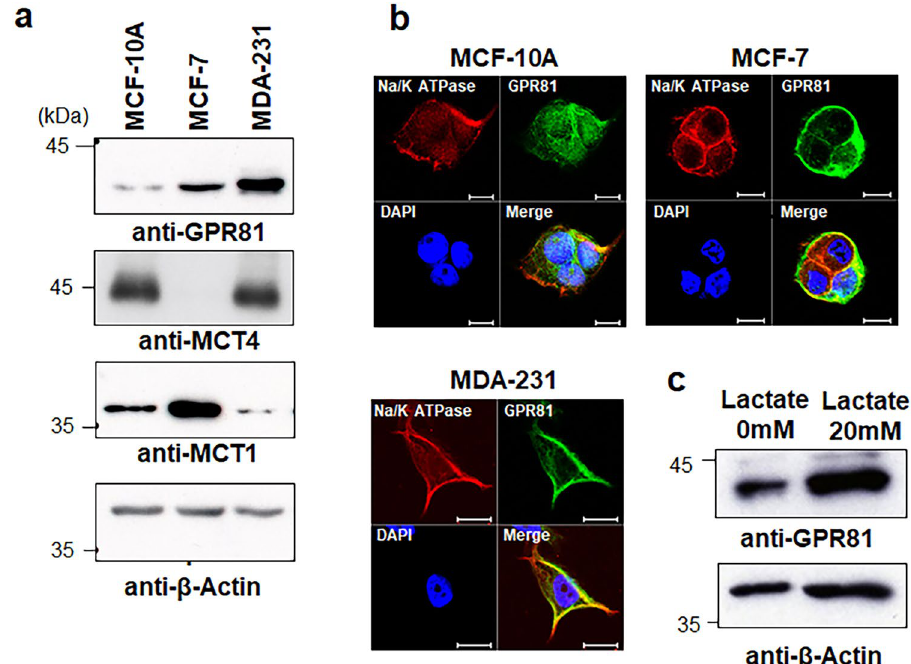
Figure 1. Expression of GPR81 in breast cancer cells. ( a ) Western blot analysis of GPR81 in breast cancer cells (MCF-7 and MDA-MB-231) and non-tumorigenic epithelial cells (MCF-10A). Cell lysates were analyzed by immunoblotting using anti-GPR81, anti-MCT4, anti-MCT1, and anti-β-actin antibodies. ( b ) Immunocytochemical analysis of GPR81 expression in breast cancer cells (MCF-7 and MDA-MB-231) and non-tumorigenic epithelial cells (MCF-10A). MCF-10A, MCF-7 and MDA-MB-231 cells were incubated with polyclonal antibodies against GPR81 followed by Alexa Fluor Plus 488-conjugated secondary antibody and visualized under a fluorescence microscope. Na/K ATPase was used as a cell membrane marker and the nuclei were stained with DAPI. Scale bar 10 μm. ( c ) MDA-MB-231 cells were cultured in the presence and absence of 20 mM lactate for 48 h, and cell lysates were analyzed by immunoblotting using anti-GPR81 and anti-β-actin